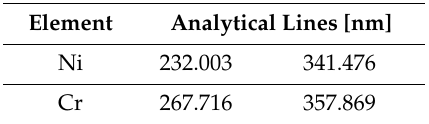
Table 3. Analytical lines used for the measurement.